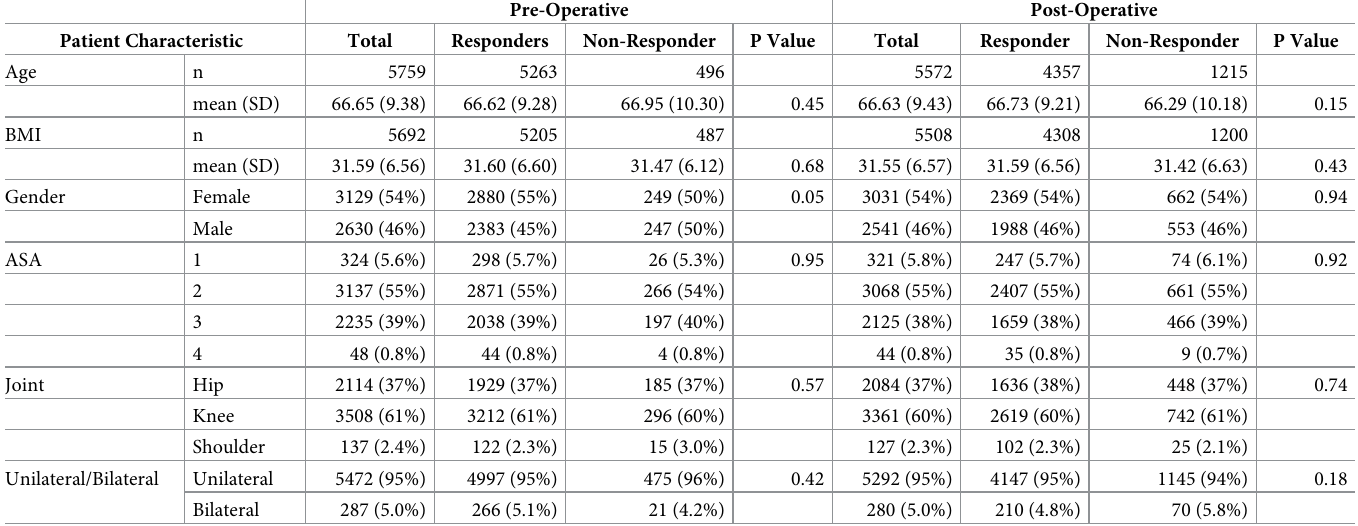
Table 2. Comparison of patients responding electronically and by telephone compared to